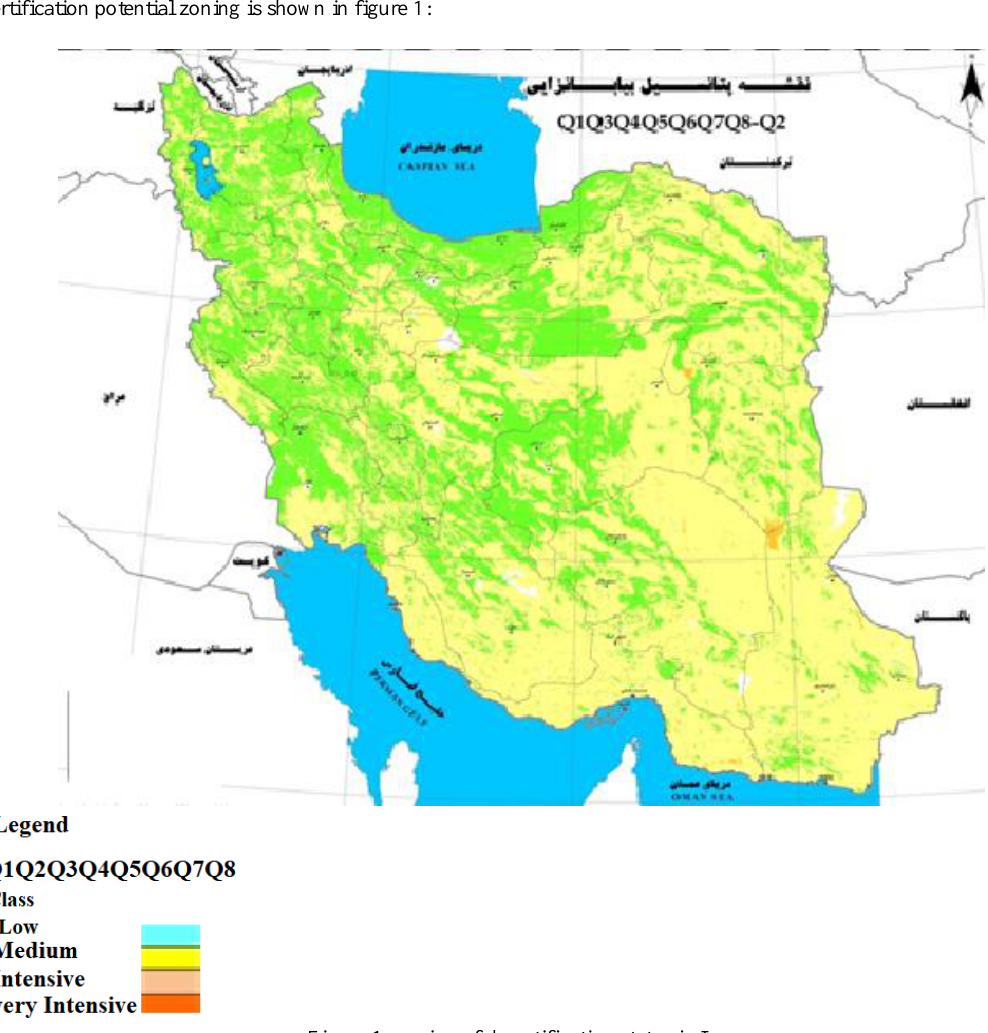
Figure 1. zoning of desertification status in